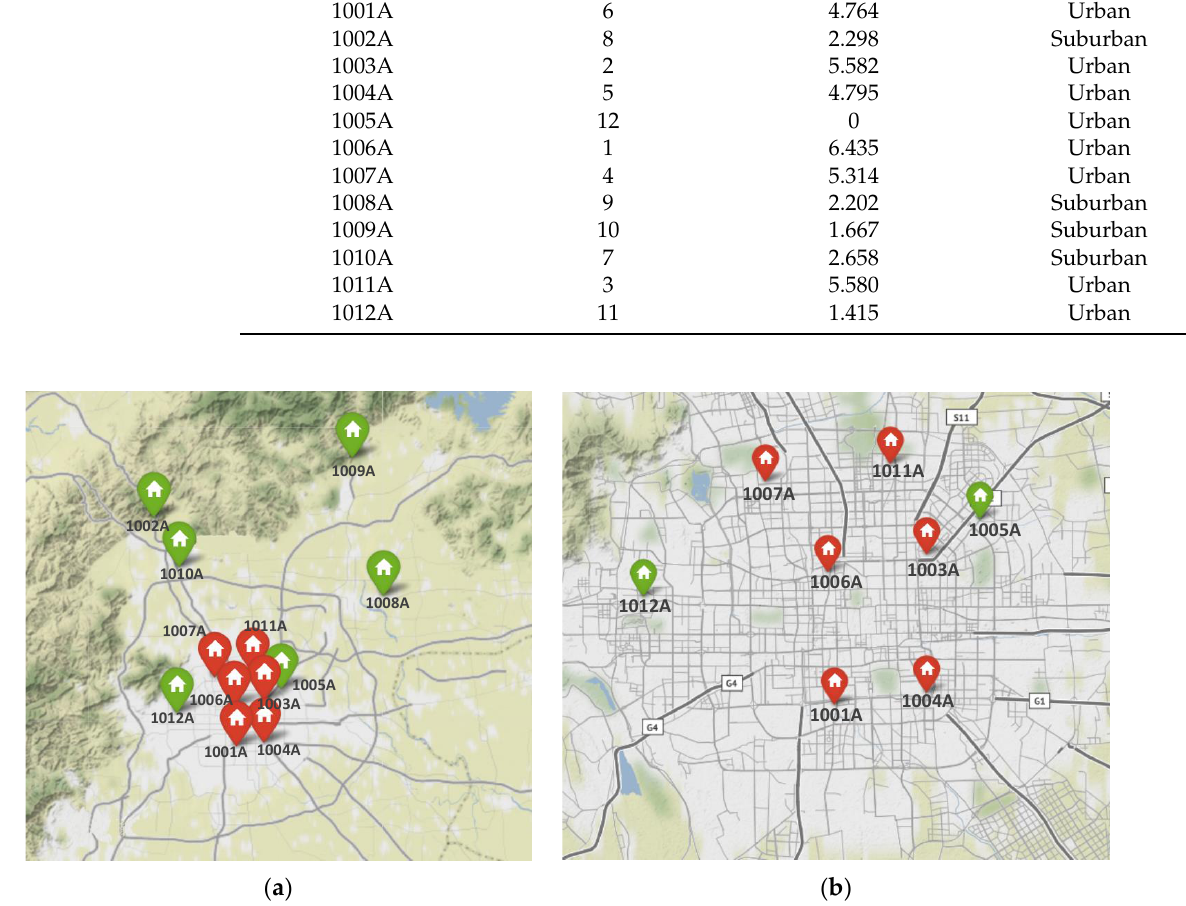
Figure 5. Maps of the locations of the 12 air quality monitoring stations in Beijing: ( a ) map of all areas of Beijing; ( b ) map of urban areas of Beijing.